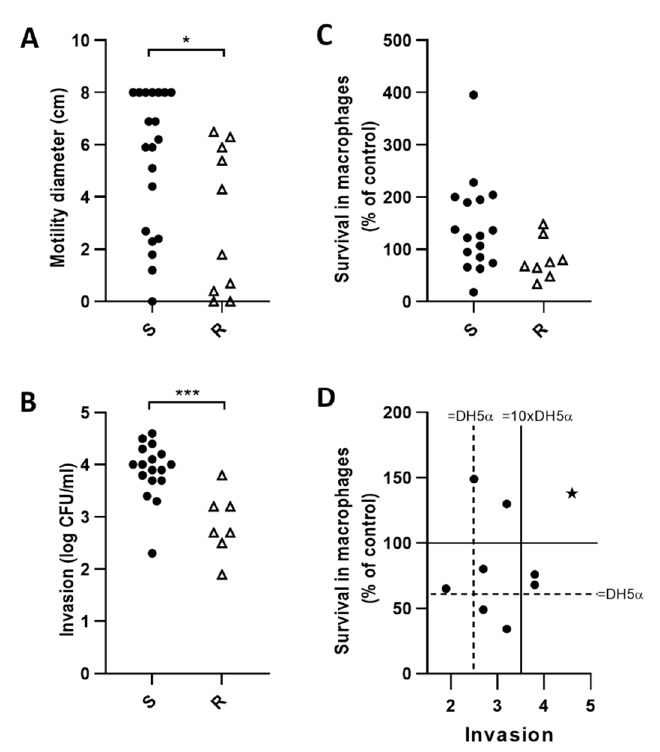
Figure 5. E ff ect of fluoroquinolone resistance on motility, invasion of epithelial cells, and survival in macrophages. ( A ) motility, ( B ) epithelial cell invasion, and ( C ) survival in macrophages. ( D ) Invasion vs. survival of FQ-R E. coli isolated from six dogs (seven biopsies; one dog was sampled before and after fluoroquinolone treatment). The star symbolled data point is fluoroquinolone sensitive (FQ-S) AIEC strain CUKD2. Mann–Whitney U, * p < 0.05, *** p < 0.001.